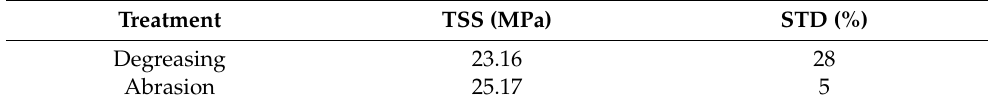
Table 7. TSS of the control joints.